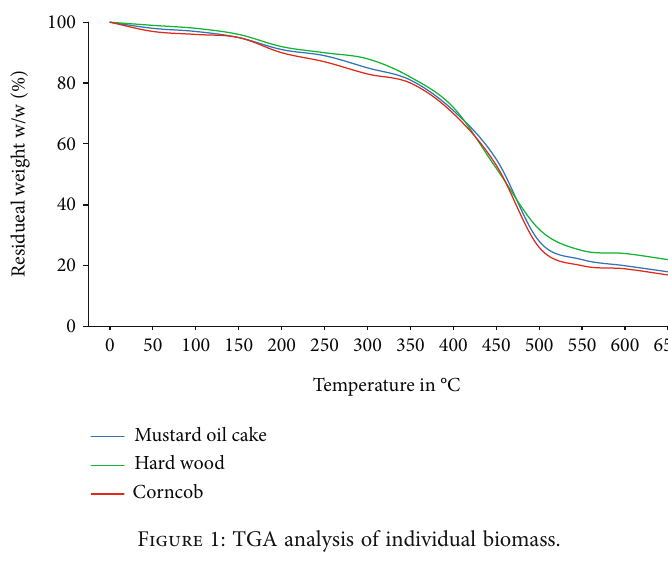
Figure 1: TGA analysis of individual biomass.